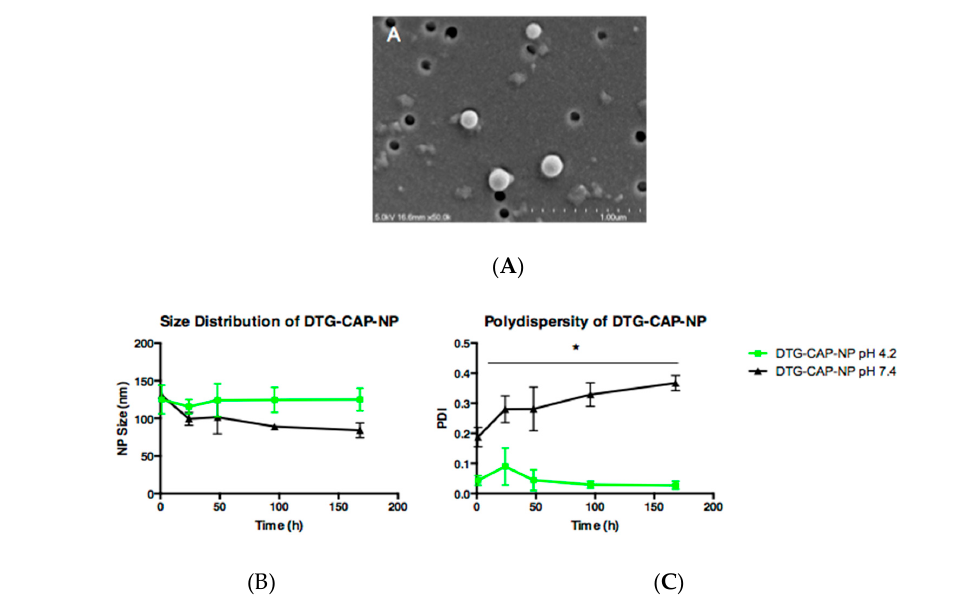
Figure 1. Characterization of DTG–CAP–NP. SEM of DTG-CAP-NP at pH 7.4. Scale bar shows 1.0